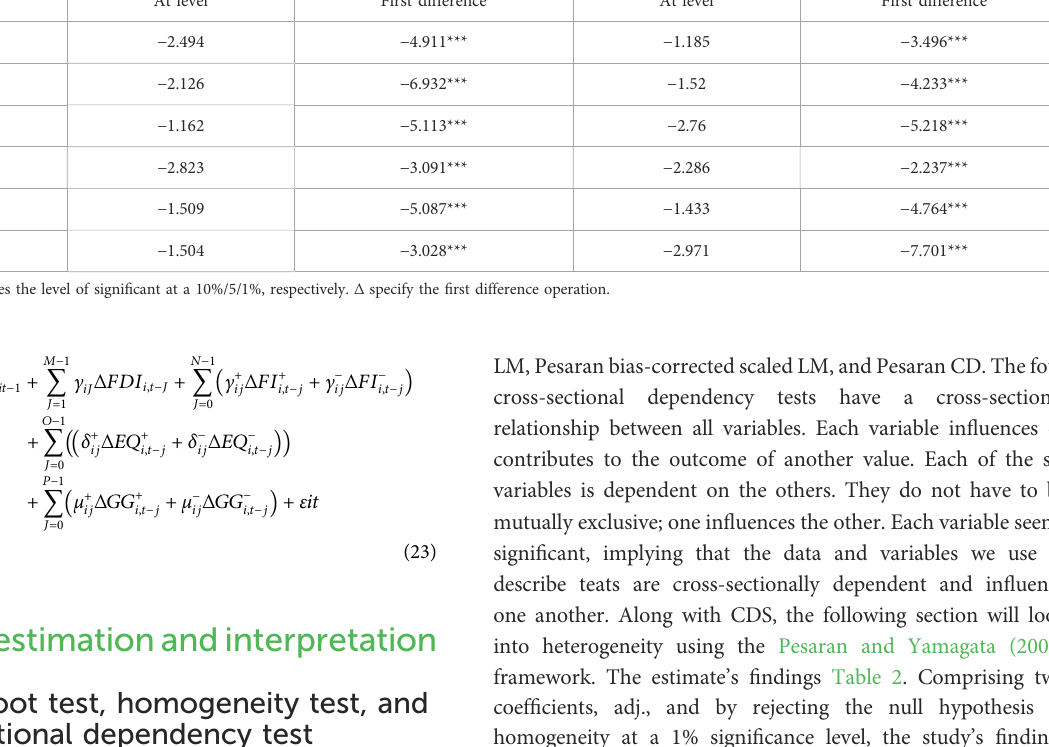
TABLE 4 Results of second-generation unit root test. CIPS CADF At level First difference At level First